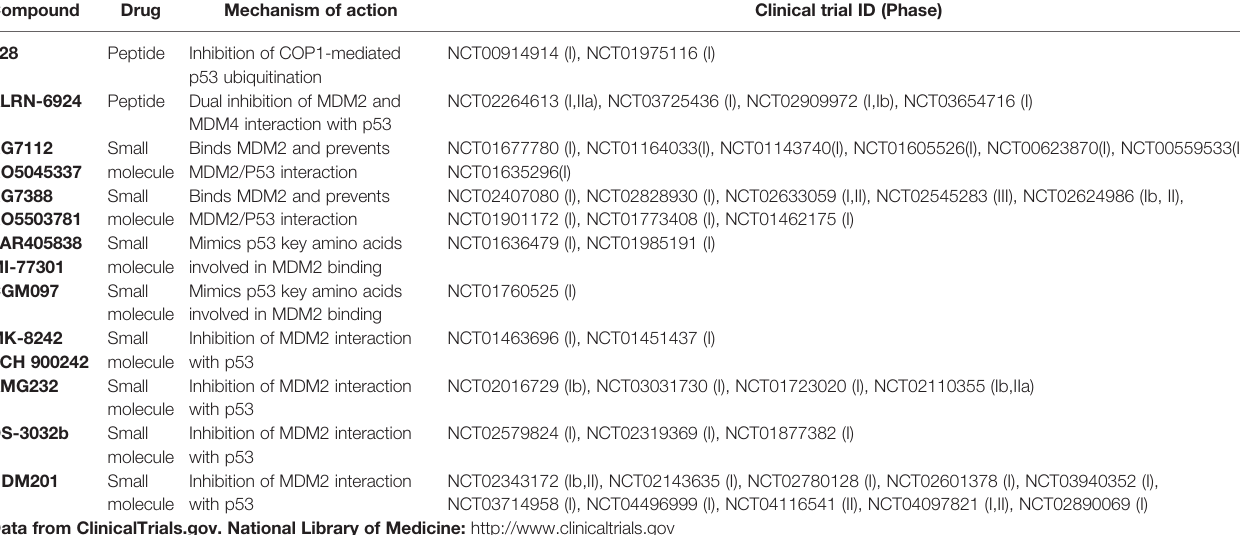
TABLE 2 | Strategies for wt-p53 re-activation, which entered clinical trial